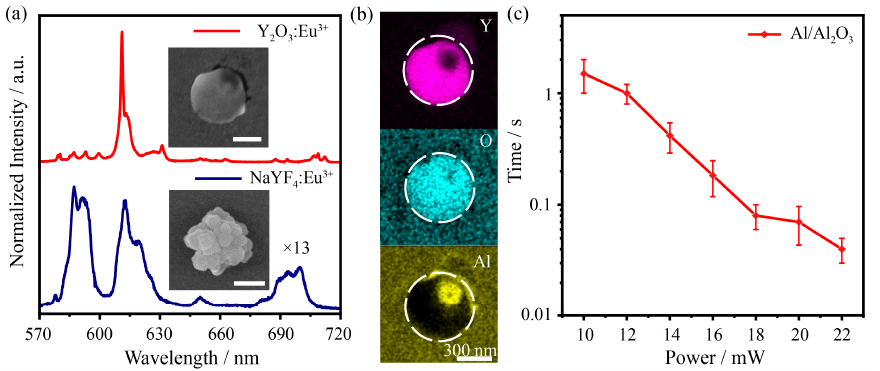
Figure 4. ( a ) In situ luminescence spectra of a Eu 3+ -doped single nanoflower before and after 976 nm laser irradiation, and inserted SEM images show the initial and transformed nanocrystal. Scale bar, 300 nm. ( b ) EDX elemental mapping of the spherical product. ( c ) Laser power dependent irradiation time.